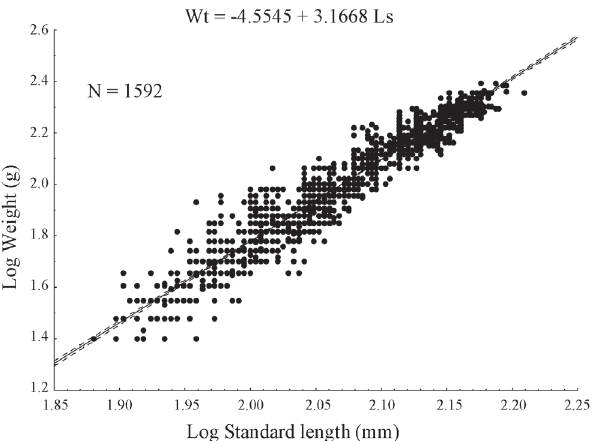
Fig. 1. Length x weight plots for specimens of Symphysodon aequifasciatus captured in Ayapuá Lake during September- November 2006 and 2007. of total weight (mean 141.22, SD +24.26). Egg size distribution